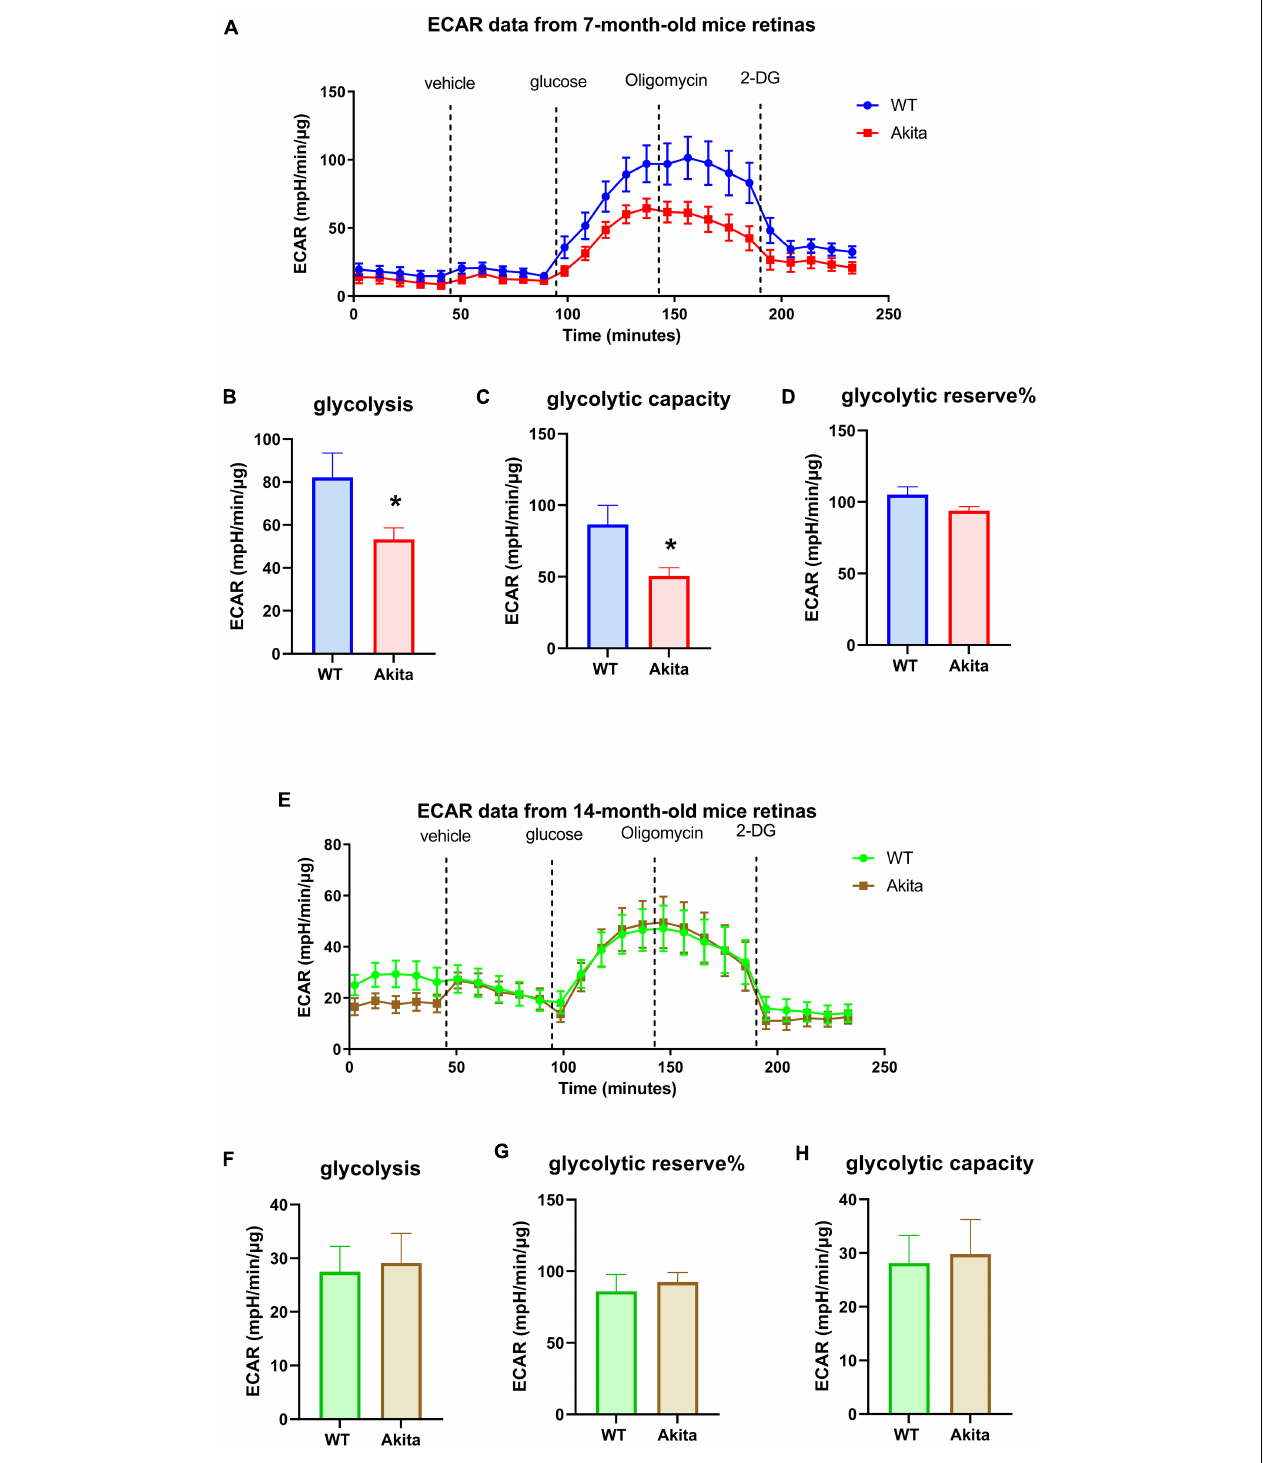
FIGURE 1 | Glycolytic response of the Ins2 Akita diabetic retina. (A–D) Seahorse glycolysis stress test conducted on retina explants from 7 months old WT and diabetic Akita mice shows a significant reduction in glycolysis and glycolytic capacity, but not glycolytic reserve in the diabetic retina as indicated by decreases in the extracellular acidification rate (ECAR) compared to the WT controls. * p < 0.05 vs. WT. N = 11. (E–H) Seahorse glycolysis stress test conducted on diabetic 14-months old retina explants show similar ECAR responses to age-matched WT retinas as presented by similar glycolysis, glycolytic capacity and glycolytic reserve. N =